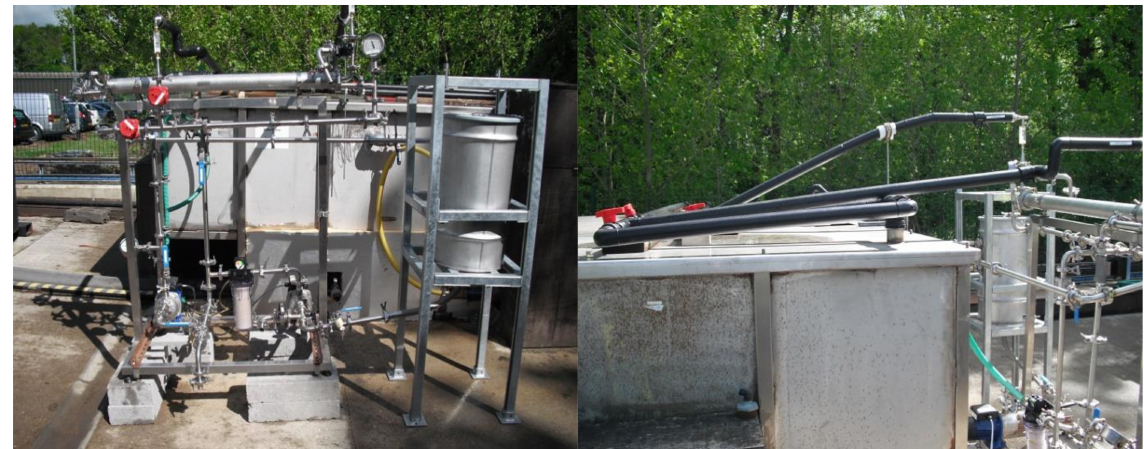
Figure 4. Pilot membrane rig used for the Bedfordshire site trials. Left: front view of the pilot. Right: connection to the existing Bedfordshire OWS